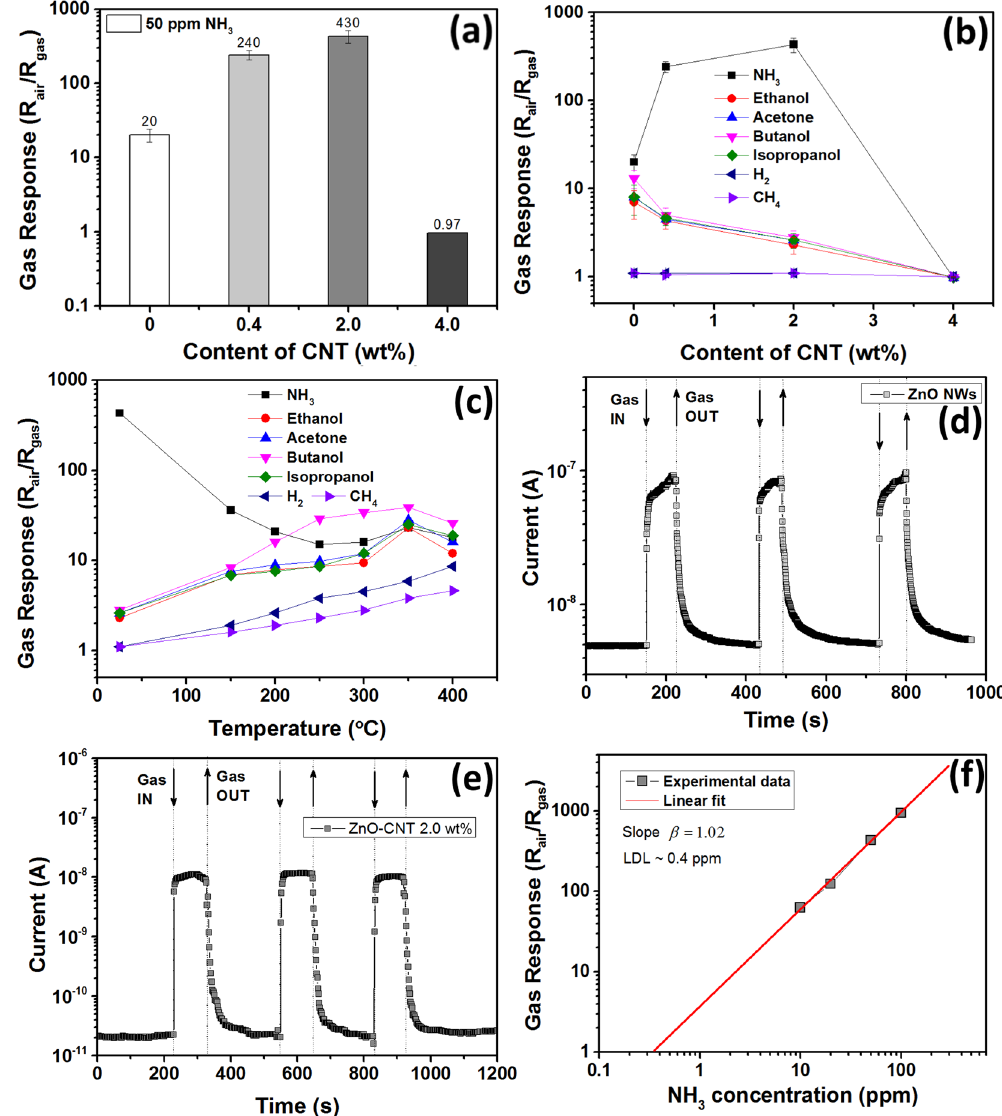
Figure 3. ( a ) The gas response of devices with different content of CNT to 50 ppm of NH 3 at room temperature. The gas response of devices with different content of CNT at room temperature ( b ); and the gas response of sample with 2.0 wt% CNT versus operating temperature ( c ) to 50 ppm of NH 3 , 100 ppm of ethanol, acetone, butanol and isopropanol and 10 000 ppm of H 2 and CH 4 . Dynamic gas response of devices with different content of CNT at room temperature to 50 ppm of NH 3 : ( d ) ZnO; and ( e ) ZnO-CNT with 2.0 wt%. ( f ) Gas response at room temperature versus concentration of NH 3 for sample with 2.0 wt%